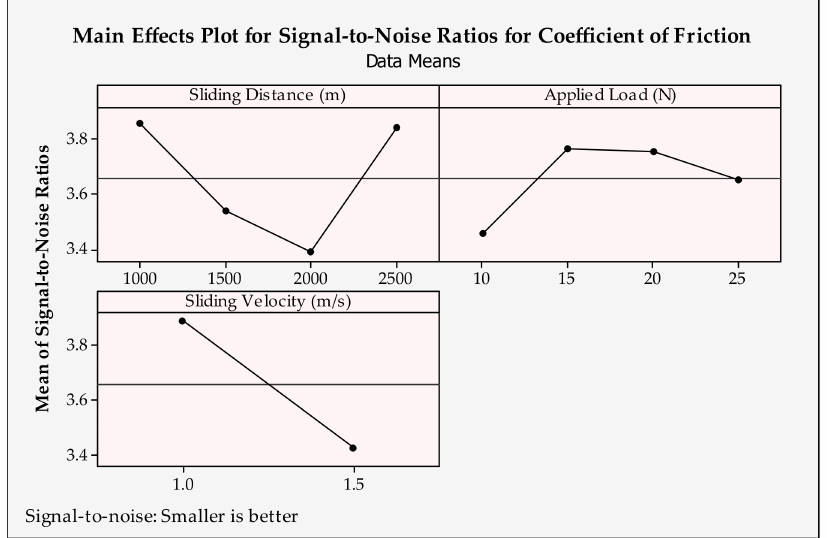
Figure 14. Signal-to-noise ratios of coefficient of friction for tribological